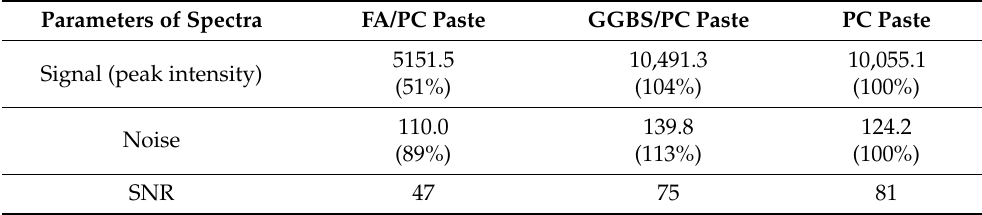
Table 2. Summary of the signal, noise and signal-to-noise ratio (SNR) of the Raman spectra of the powders collected at a depth of 0–2 mm of the carbonated FA/PC, GGBS/PC and PC paste samples.